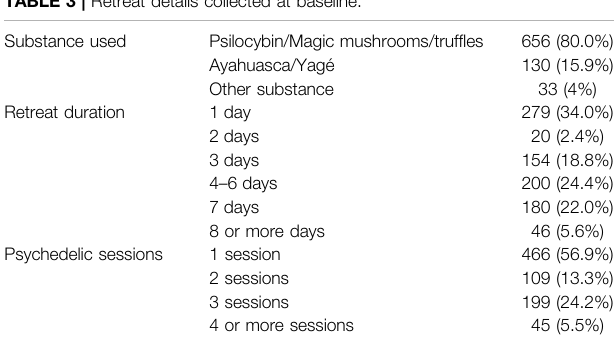
TABLE 2 | Demographic information collected at baseline. TABLE 3 | Retreat details collected at